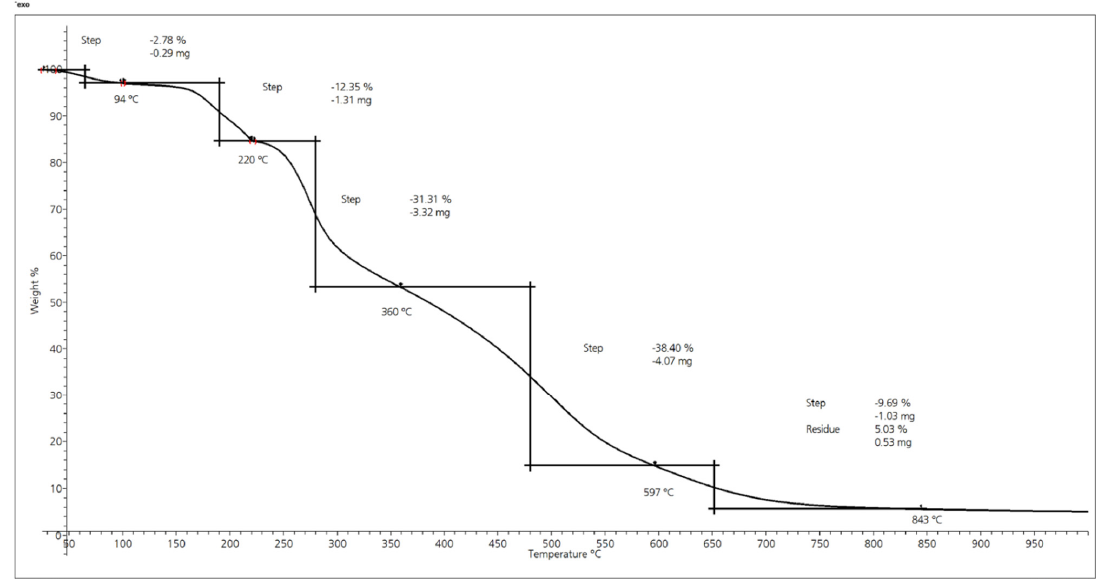
Figure 16. Thermal degradation steps for wheat straw particles.